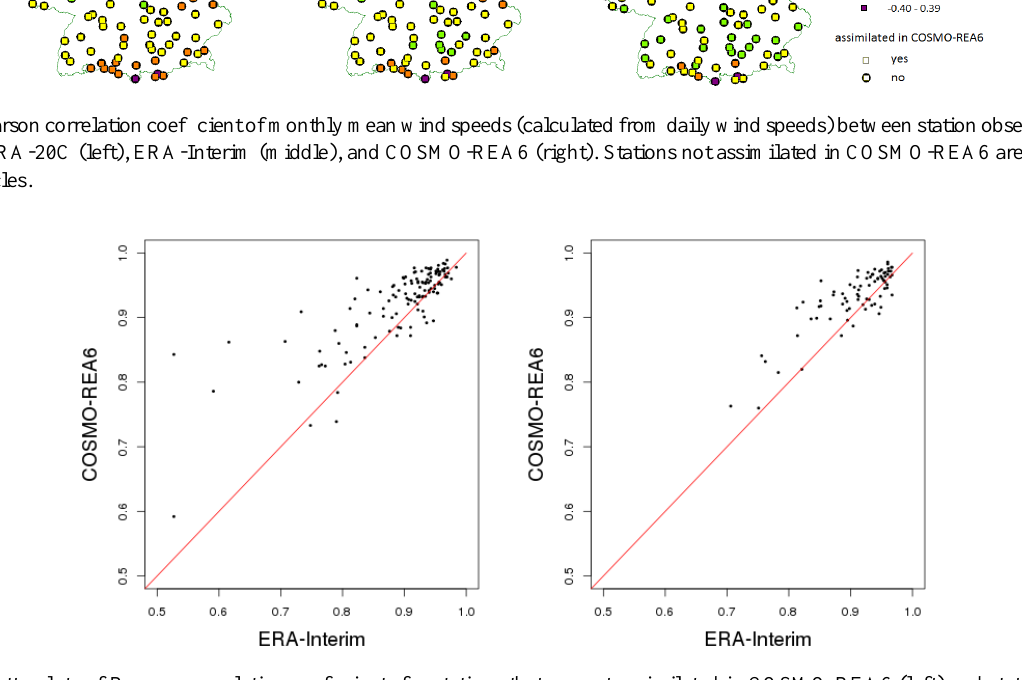
Figure 9. Scatterplots of Pearson correlation coefficients for stations that are not assimilated in COSMO-REA6 (left) and stations that are assimilated (right). Correlations are calculated between monthly mean wind speeds of station observations and COSMO-REA6 ( y axis) and compared to correlations between station observations and ERA-Interim ( x axis), respectively. Three of the total 210 stations are outliers (correlation below 0.5) and are not